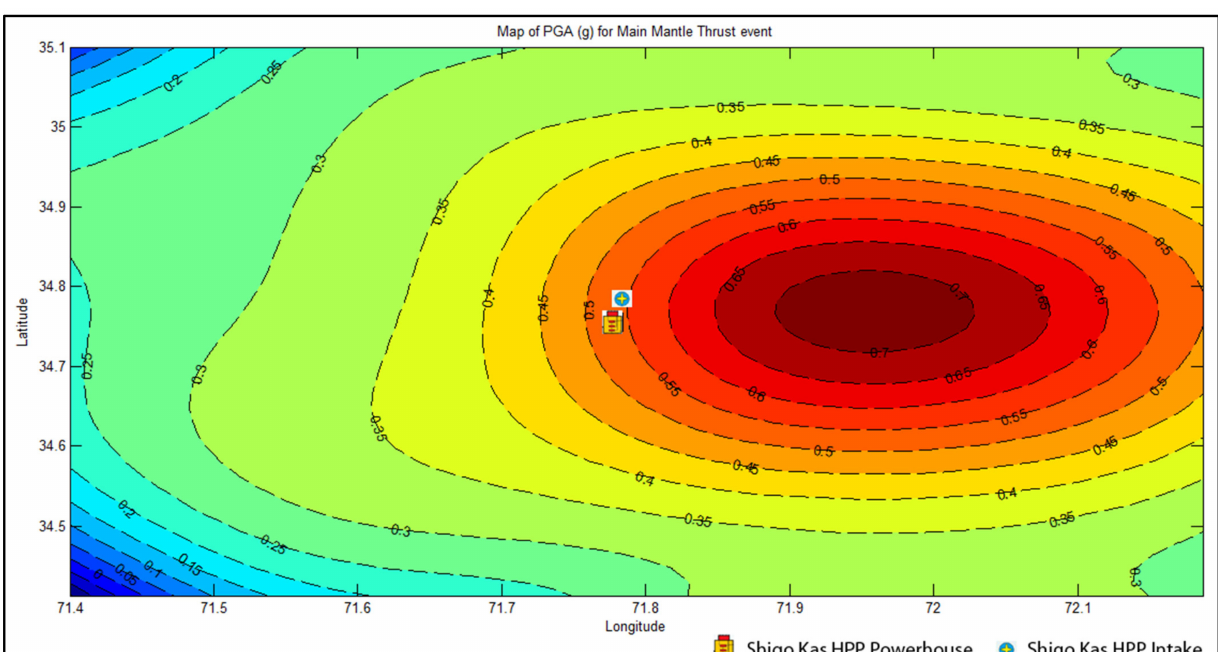
Figure 12. Hazard map for the Shigo Kas HPP in terms of ground acceleration